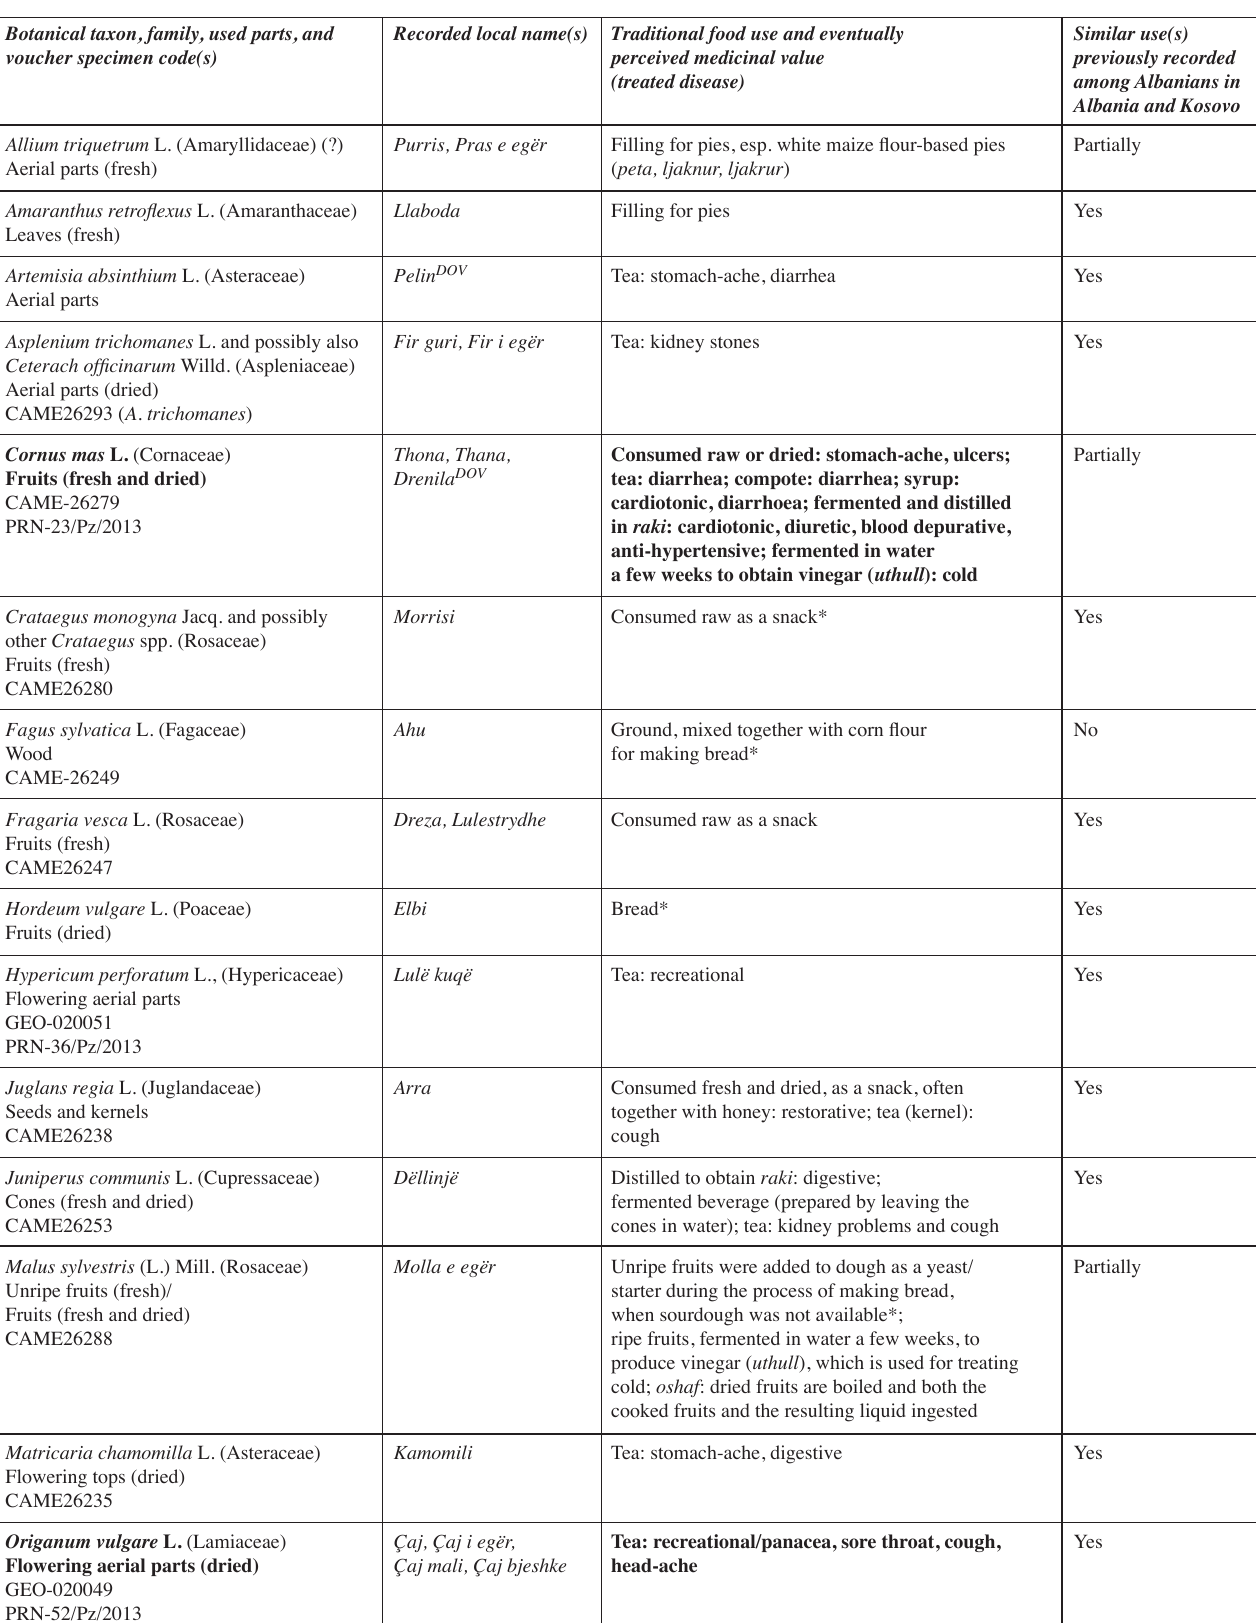
Tab. 1: Wild food plants and their traditional uses recorded in the study area (a few cultivated and semi-domesticated plants used in uncommon ways are also included) Botanical taxon, family, used parts,